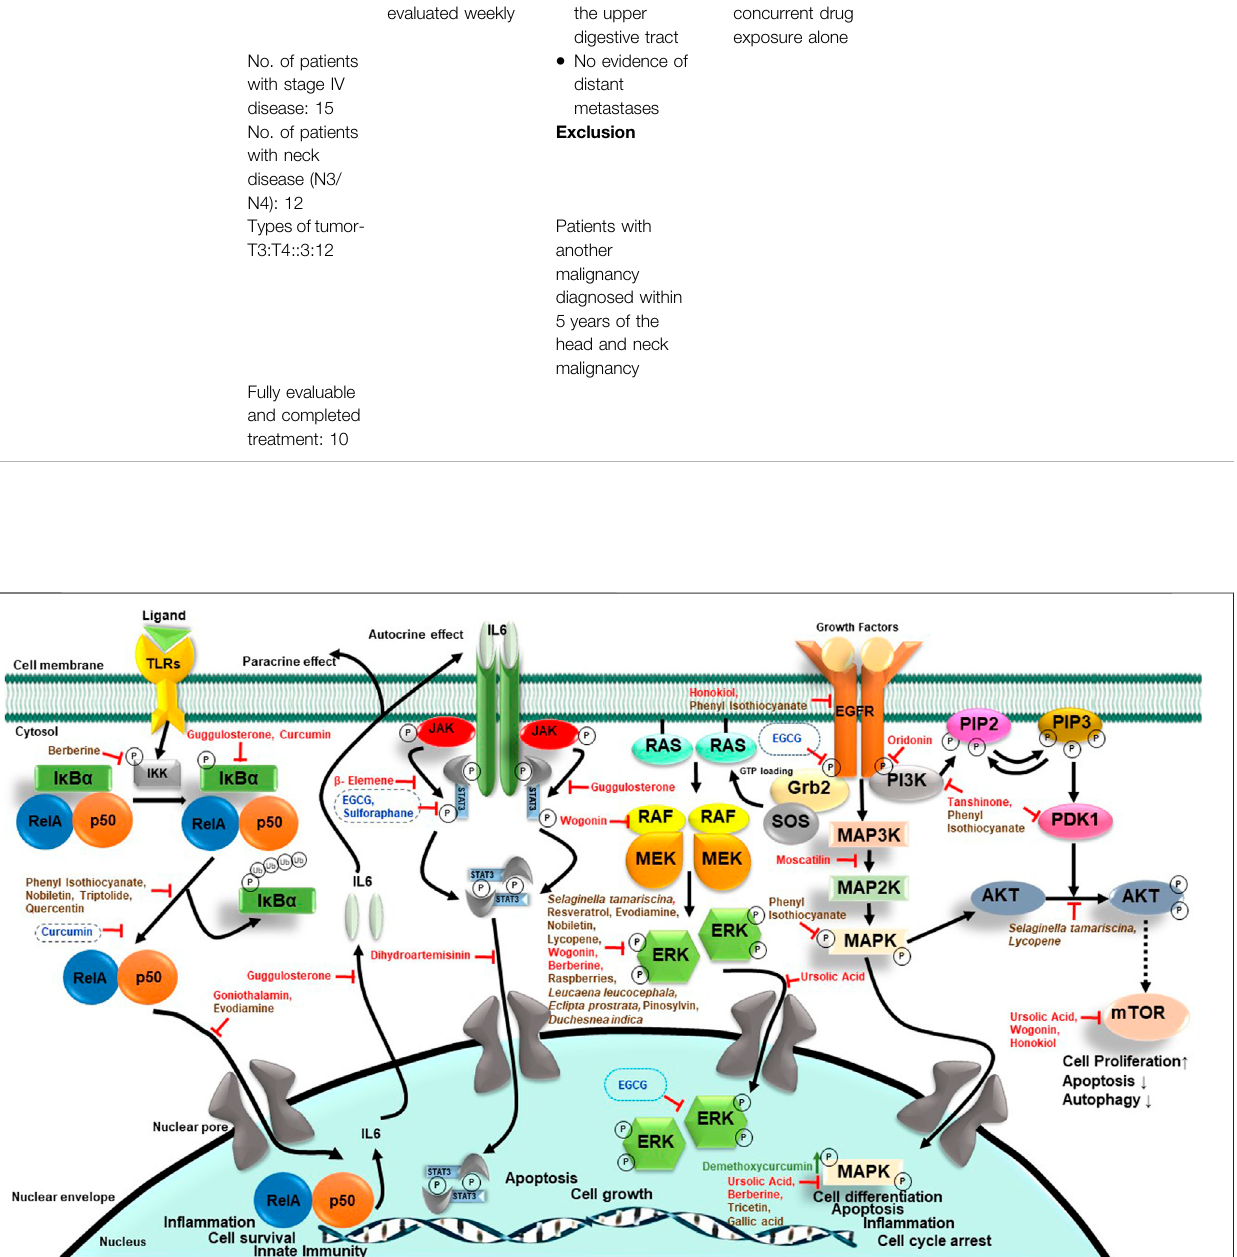
Frontiers in Pharmacology |